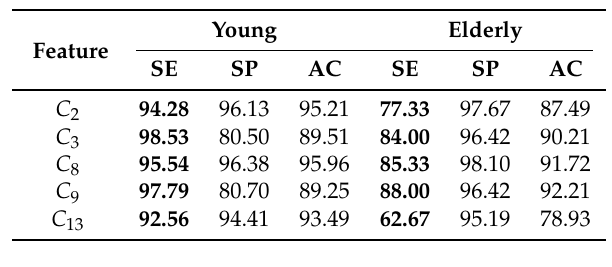
Table 5. Sensitivity (SE), specificity (SP) and accuracy (AC) after training with young adults and validating either with young adults or elderly